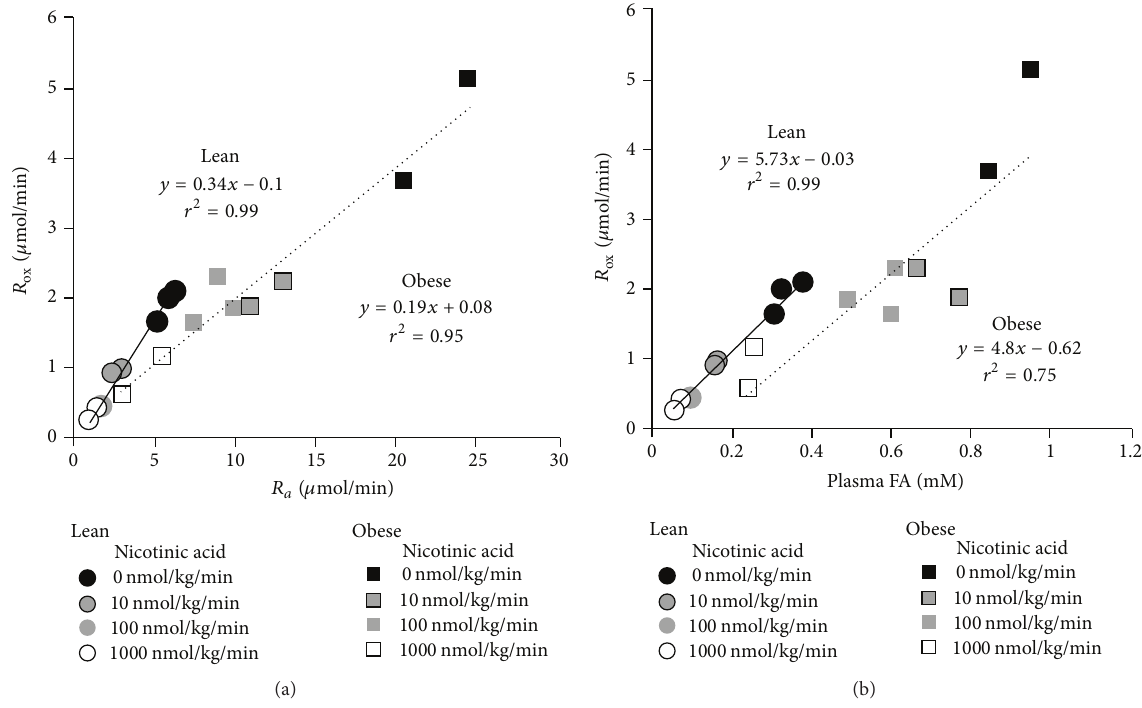
Figure 3: Dependence of FA oxidation ( 𝑅 ) on both the rate of FA appearance, 𝑅 𝑎 (a), and FA level (b), in lean and obese Zucker rats. FA ox availability has been pharmacologically manipulated using the antilipolytic agent nicotinic acid to generate a range of FA levels ( 𝑛 = 2 - 3 rats per dose).